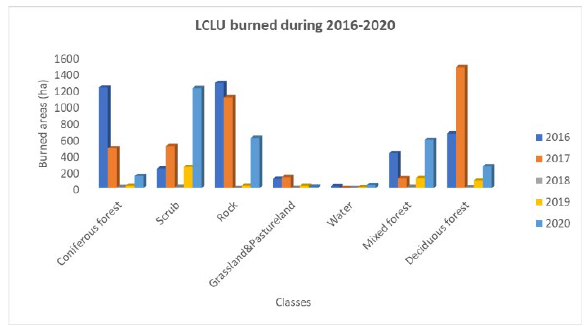
Figure 7 . LCLU classes burned during 2016-2020 years in the study